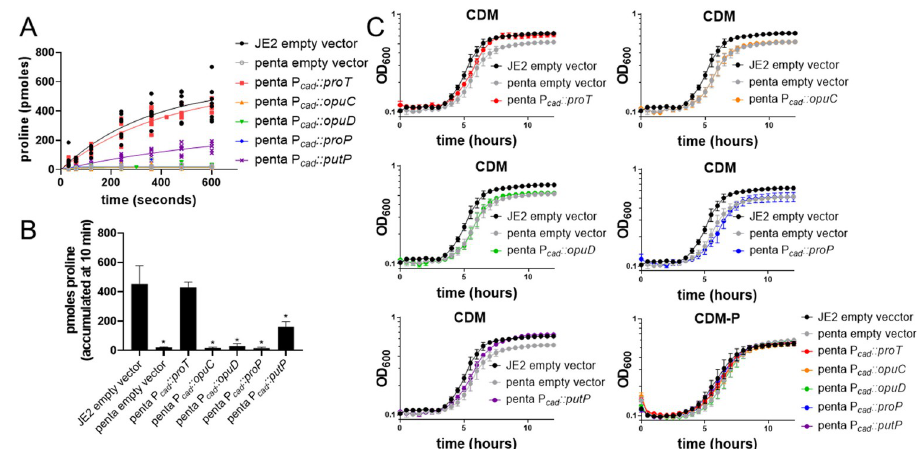
Fig 3. Proline is not transported by OpuC, OpuD, or ProP. A) 3 H-proline transport assays, B) measured amounts of proline accumulated at 10 minutes, and C) growth analysis in CDM and CDM-P of JE2 and penta pBK123 (empty vector), pML1 (P cad :: proT ), pML2 (P cad :: opuC ), pML3 (P cad :: opuD ), pML4 (P cad :: proP ), and pML5 (P cad :: putP ) confirm OpuC, OpuD, and ProP do not transport proline under these conditions. 3 H-proline transport data (A) are standardized to JE2 to account for experimental variations and are fit by nonlinear regression using a first-order equation of technical duplicates ran three independent times. Accumulated proline data (B) are represented by the mean ± SD (n = 5–6). Kruskal-Wallis multiple comparisons identified statistically significant differences ( � p < 0.05). Growth analysis data (C) are represented by the mean ± SD (n = 3).